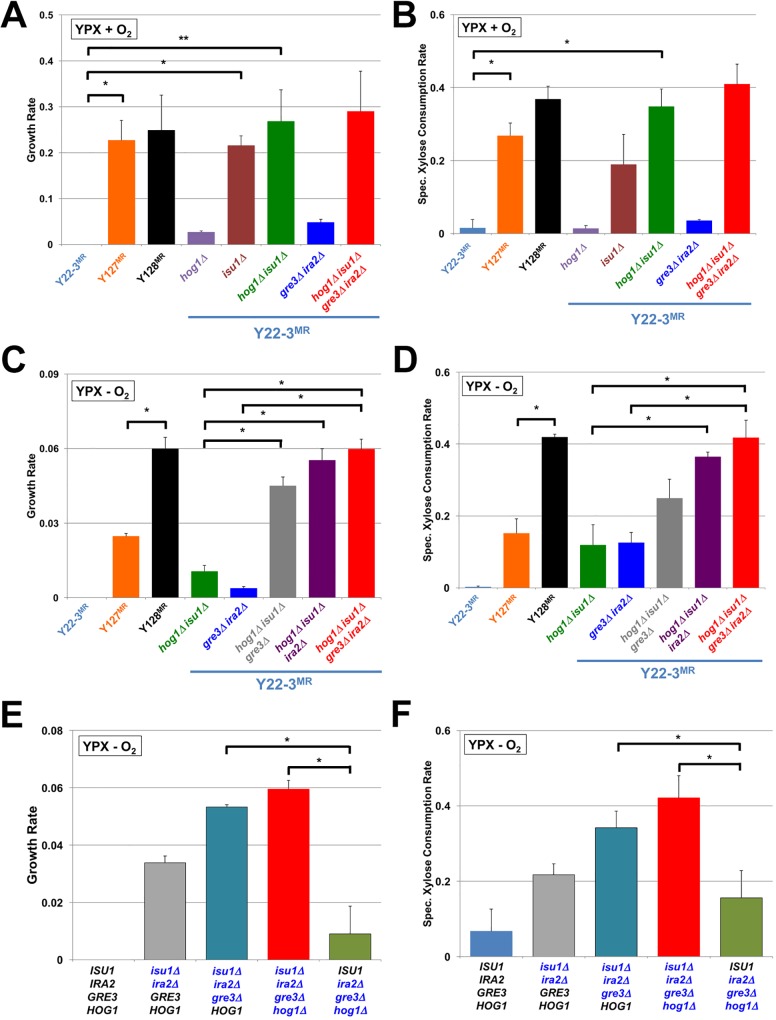
Deletions of ISU1, HOG1, GRE3 and IRA2 are sufficient to increase cell growth and xylose consumption rates.Indicated strains were cultured in YPX media under aerobic (A-B) or anaerobic (C-F) conditions. Average growth and specific xylose consumption rates with standard deviations are reported in g of dry cell mass•hr-1 (A, C) or OD600•hr-1 (E), and g of xylose consumed•g of dry cell mass-1•h-1 (B, D) or g of xylose consumed•OD600-1•h-1 (F), respectively, from the indicated strains cultured in YPX media from three independent biological replicates. Asterisks denote statistically significant differences (*; P < 0.05, **; P < 0.061) between specified strains by paired Student’s t-test. Xylose consumption rates for all strains in (D) were significantly faster (P < 0.05) than Y22-3MR.